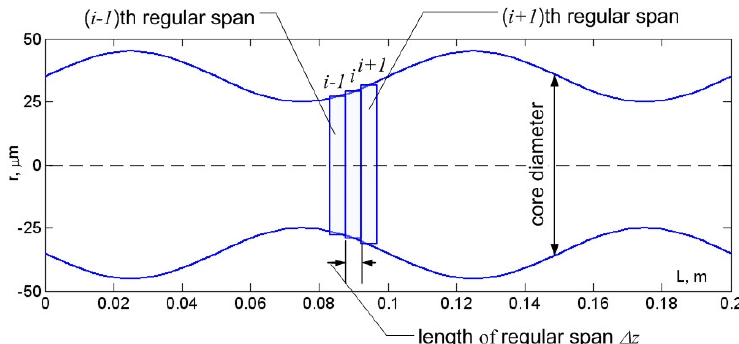
Figure 1. Piecewise regular representation of 200 m of irregular optical fiber with varying core diameters.